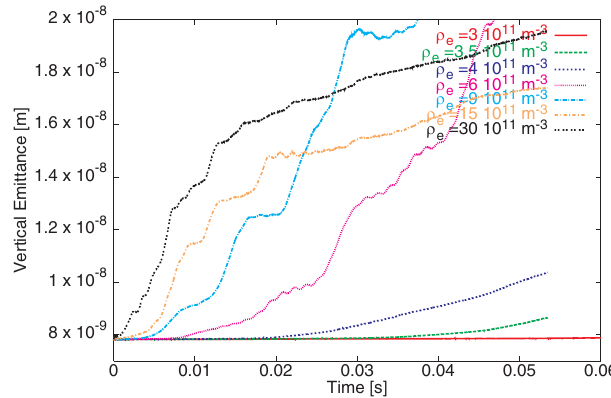
FIG. 9. (Color) Vertical emittance as a function of time for different values of bunch intensities, for LHC at injection, (cid:2) (cid:2) 6 (cid:6) 10 11 m (cid:4) 3 , and Q 0 (cid:2) 2 .